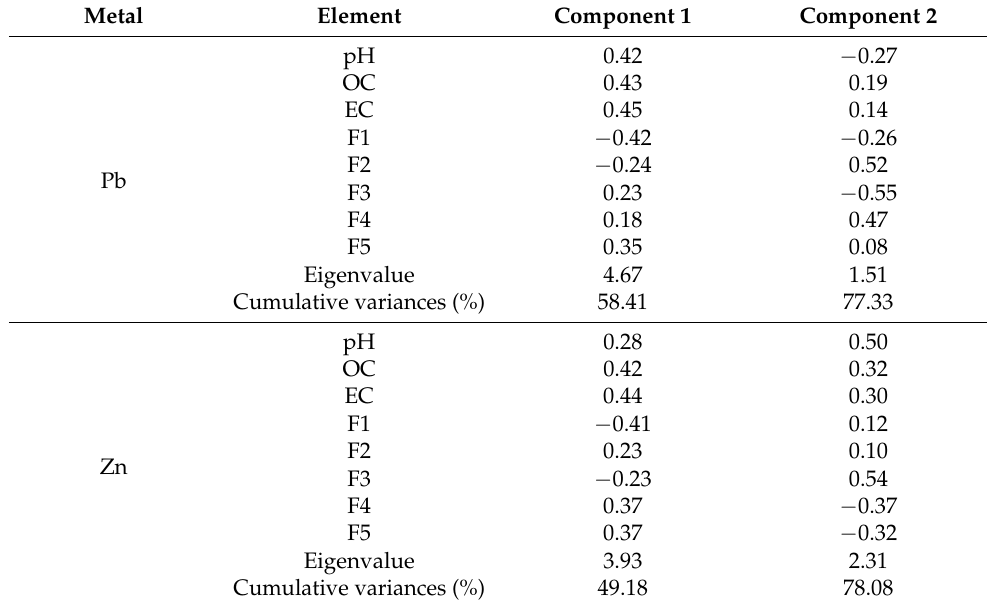
Table 4. Component matrix of the data of the chemical fractions of Pb and Zn with other factors (OC, pH, EC) in the studied samples after a 30-day